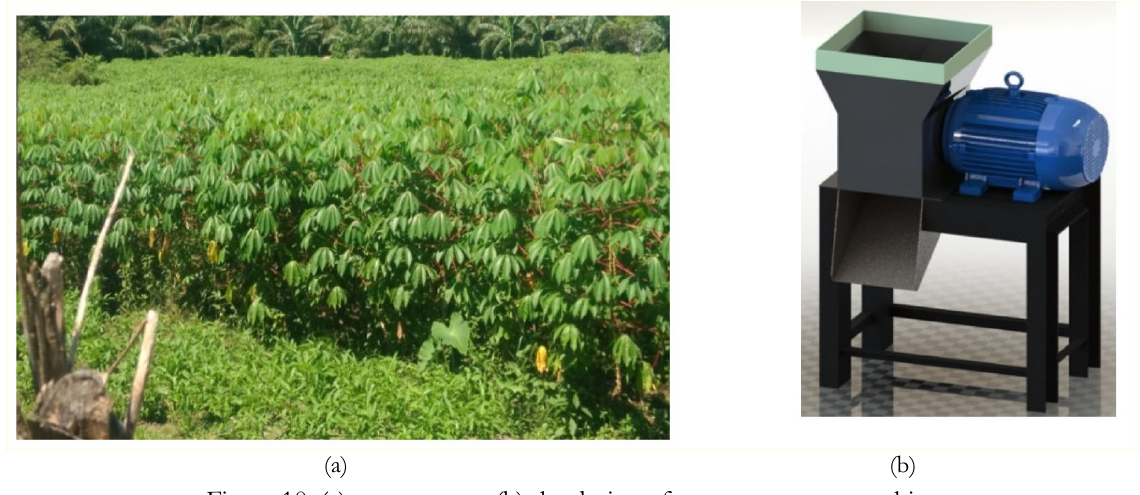
Figure 10. (a) cassava trees (b) the design of a cassava grater